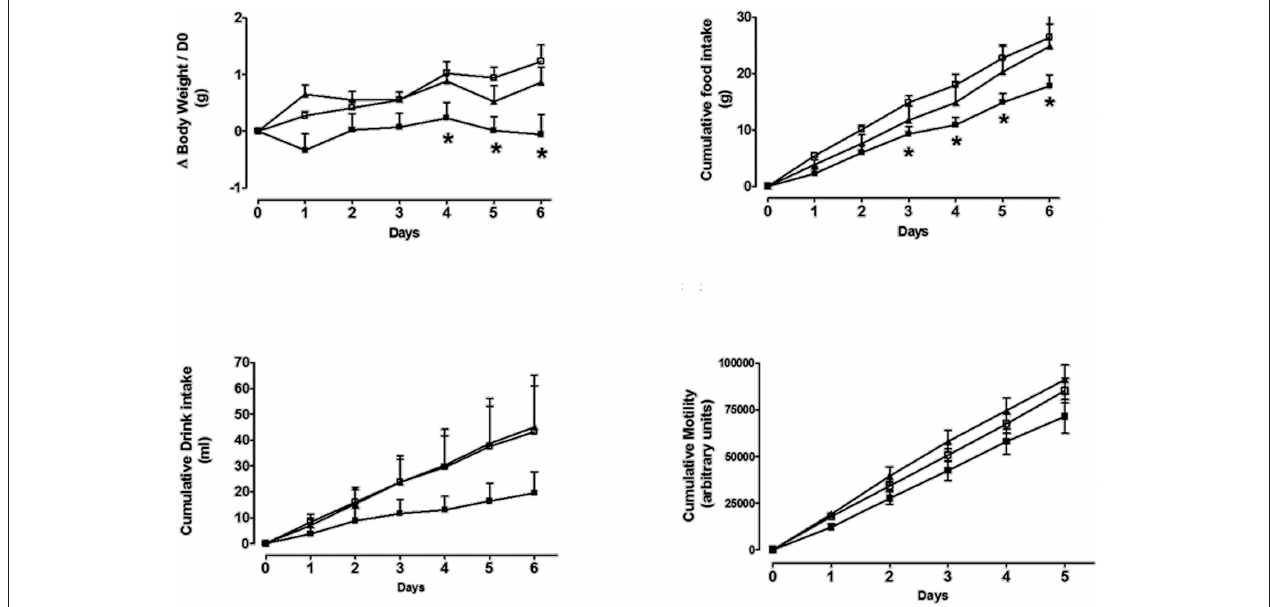
FIGURE 8 | The effects of repeated daily S38151 injection on food and water intake, body weight, and motility in ob/ob mice. Genetically modified ob/ob mice were administered S38151 (10 and 30mg/kg, i.p.) or vehicle (normal saline i.p.) for 6 consecutive days. Results are expressed as mean ± SEM ( n = 8 mice per group). White